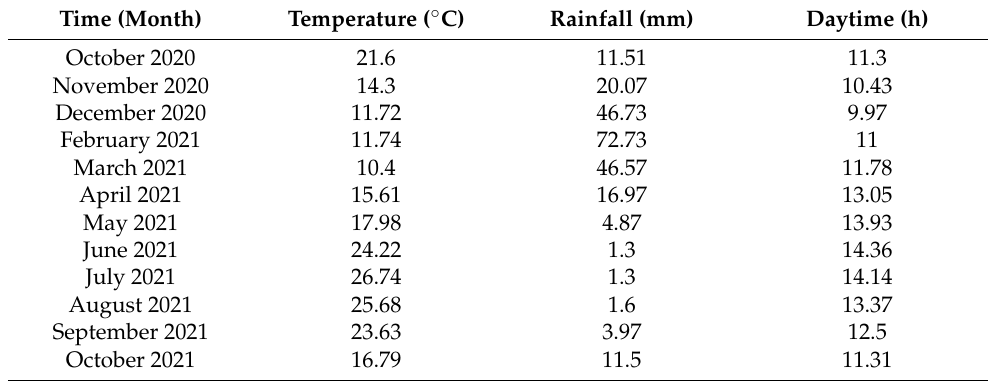
Table 2. Monthly meteorological